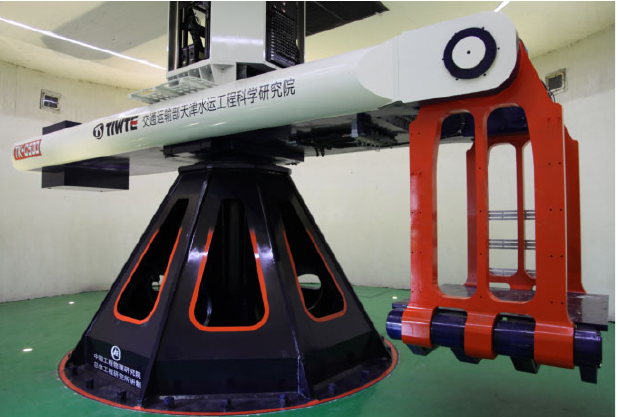
Figure 1. A real view of the geotechnical centrifuge TK-C500 utilized in the test. The physical model consists of a revetment breakwater, an aircraft runway, and their coral sand foundation, in which the breakwater is composed of a near S-shaped revetment and a caisson. The schematic map of the physical model is illustrated in Figure 2. Considering the effect of water, the water depth is set to 50 mm in the test.